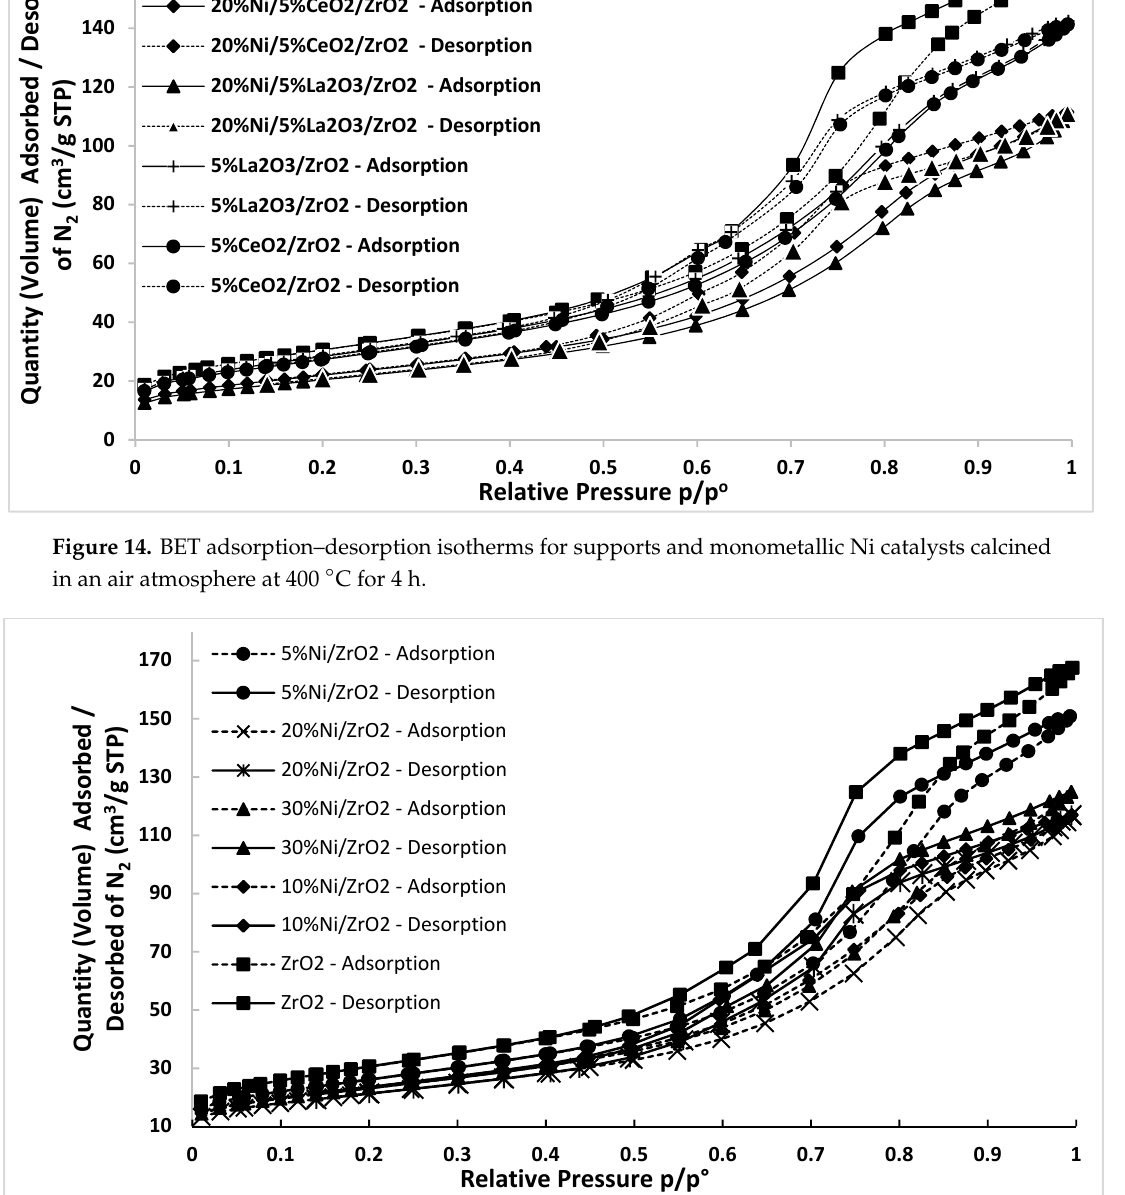
Figure 15. BET adsorption–desorption isotherms for monometallic Ni catalysts calcined in an air atmosphere at 400 °C for 4h.